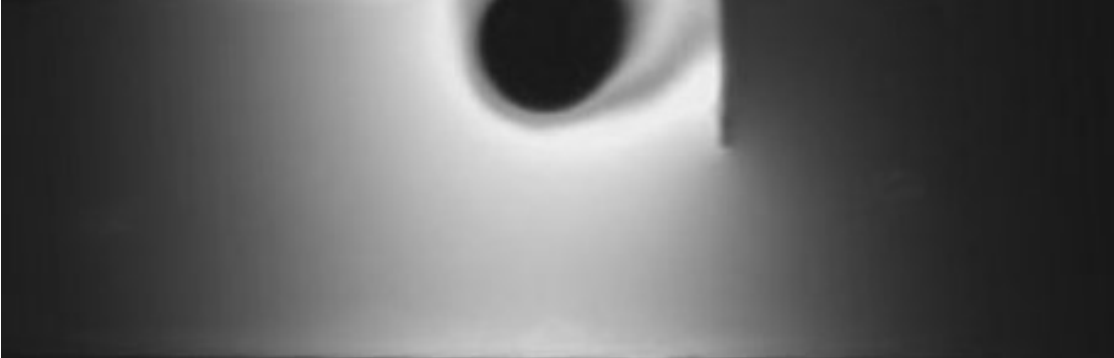
Figure 13. Heat diffusion map taken by the IR camera.